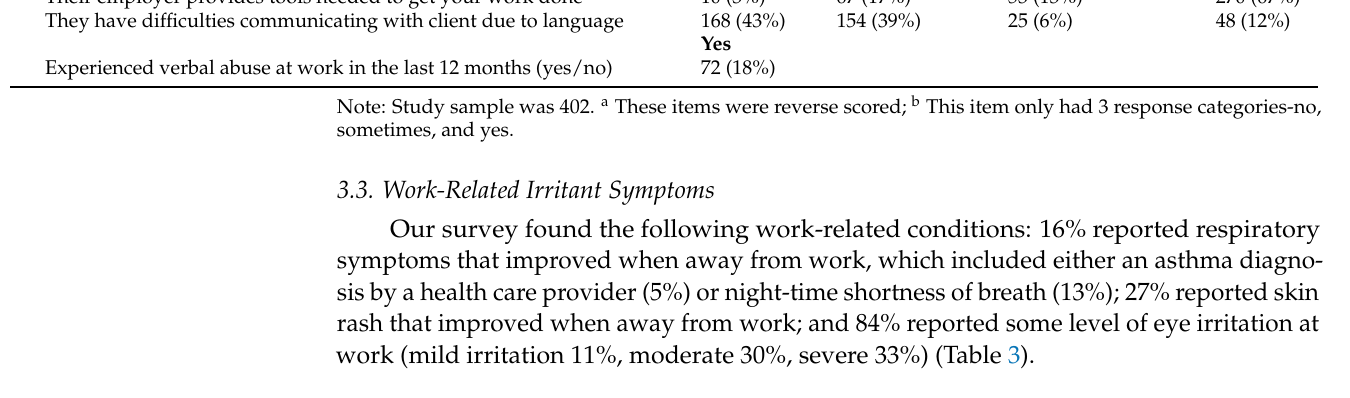
Table 3. Work-related Irritant Symptoms, Depression, Perceived Stress, and Self-Reported